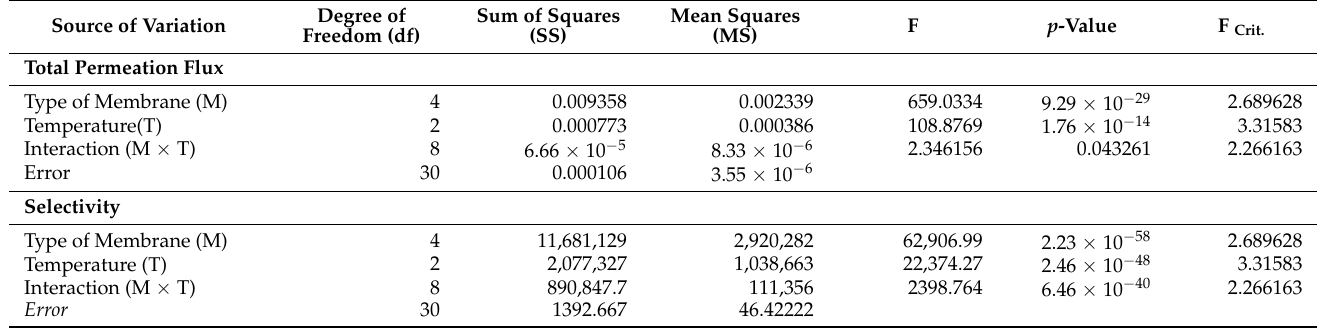
Table 2. Analysis of variance for total permeation flux and selectivity vs. membrane type and